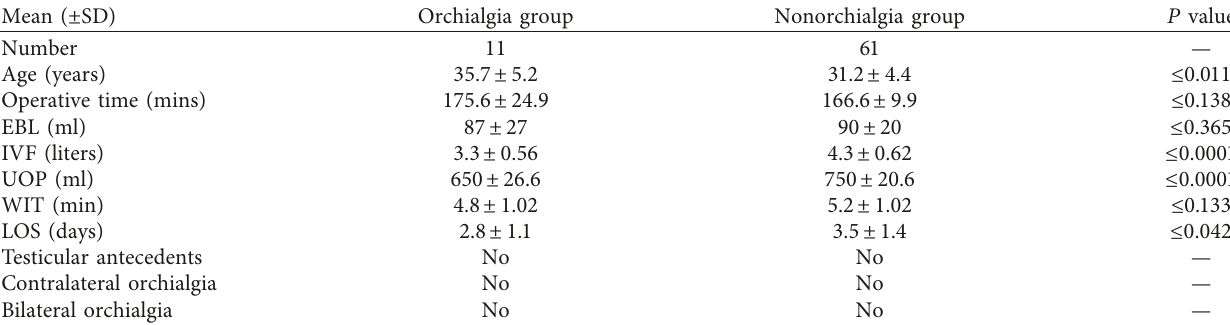
Table 2: Orchialgia vs. nonorchialgia in LESS DN patients.